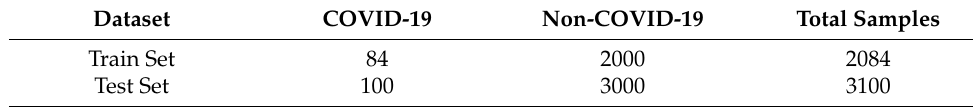
Figure 2. The architecture of the deep neural network for COVID-19 diagnosis. The performance of these pre-trained models is evaluated on COVID-Xray-5k dataset. The COVID-Xray-5k dataset is divided into 2084 training and 3100 test images. Out of 2084 training samples, 84 are COVID-19 images, and 2000 are non-COVID-19 images. On the other hand, there are 100 COVID-19 images and 3000 non-COVID-19 images in the test set. The distributions of the training and testing sets are presented in Table 2. Table 2. The number of training and testing samples in the COVID-Xray-5k